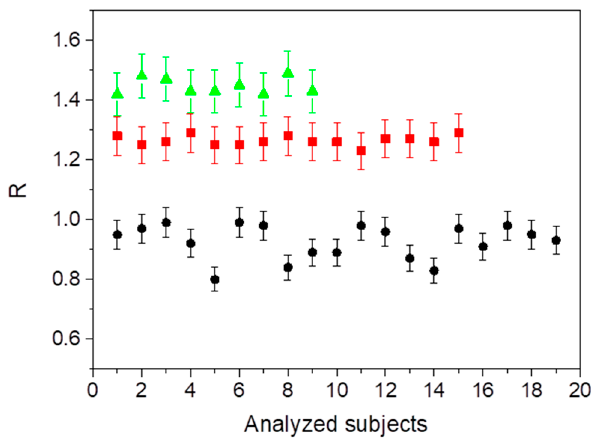
Figure 4. Calculated values of the ratio R for the analyzed non-IBD (black circles), with CD (red squares), and with UC (green triangles) subjects.